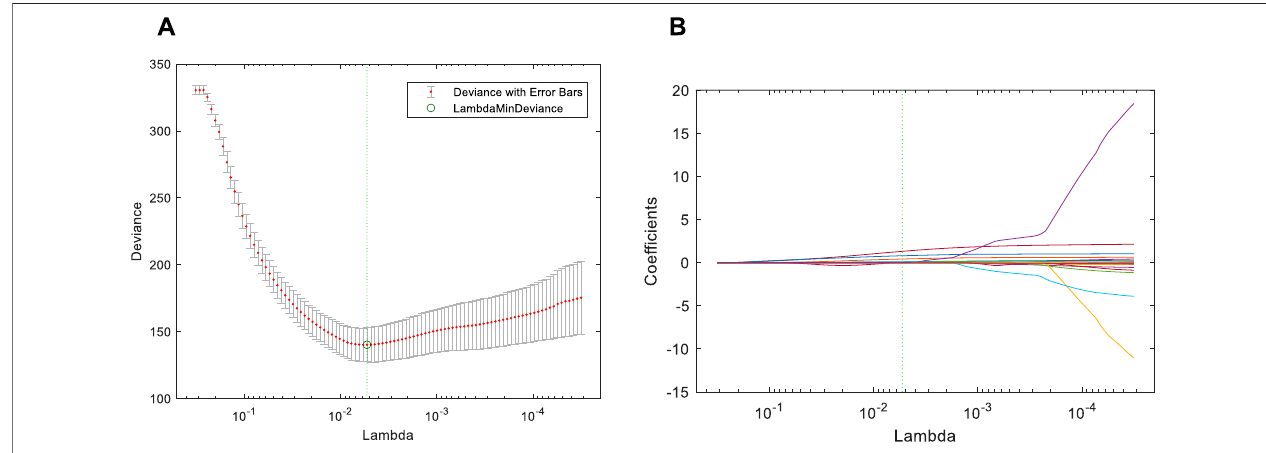
FIGURE 2 | Implementation results of the EN. (A) Deviance variation curves. The circle at the green dotted line in the fi gure refers to the minimum deviance point. The value of minimum λ based on the deviance criterion is 0.0053; (B) Variation track of coef fi cient. The position of the green dotted line corresponds to different coef fi cients.